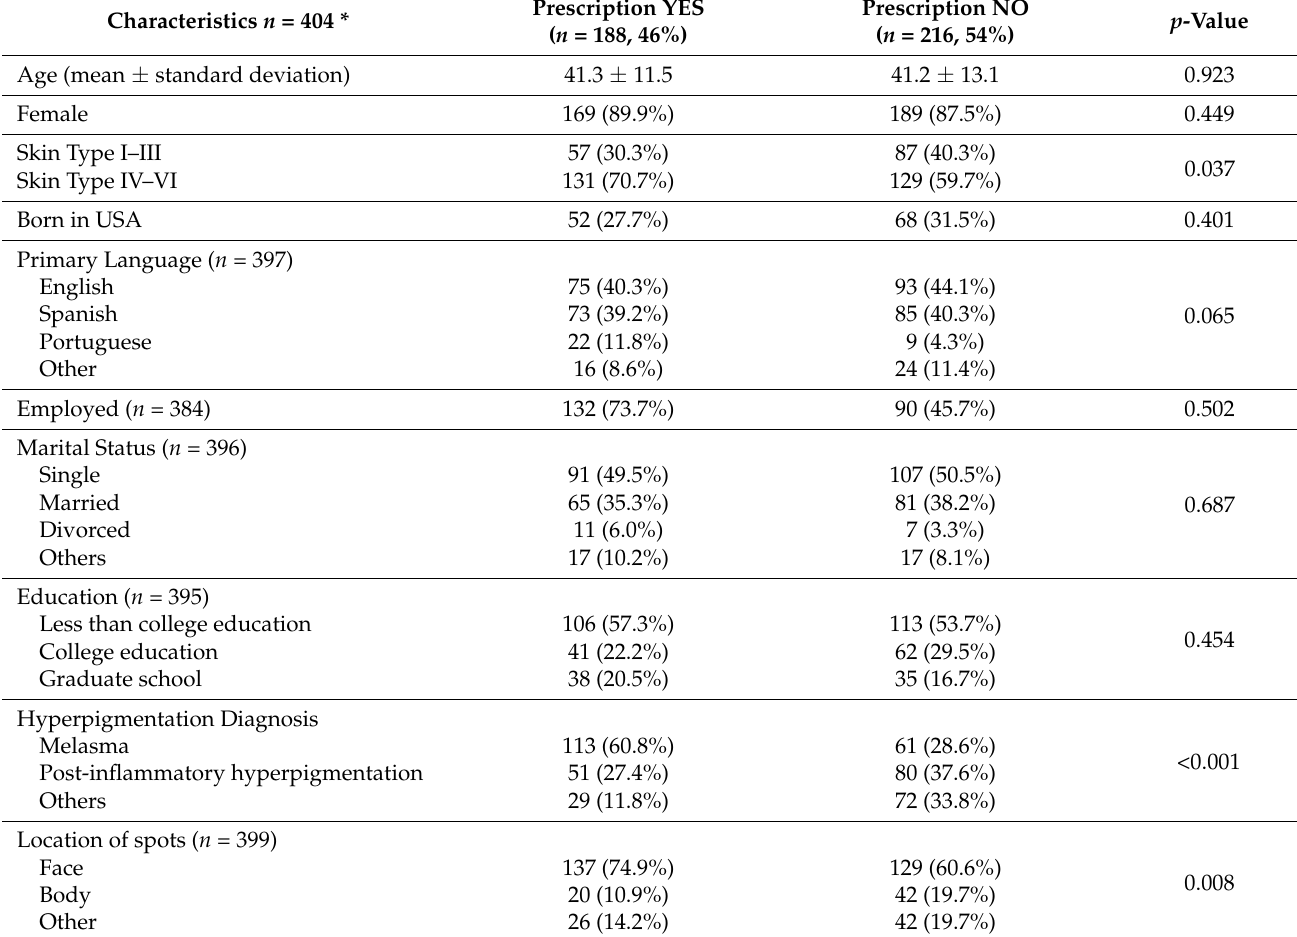
Table 1. Comparison of characteristics between patients using or not using prescription lightening